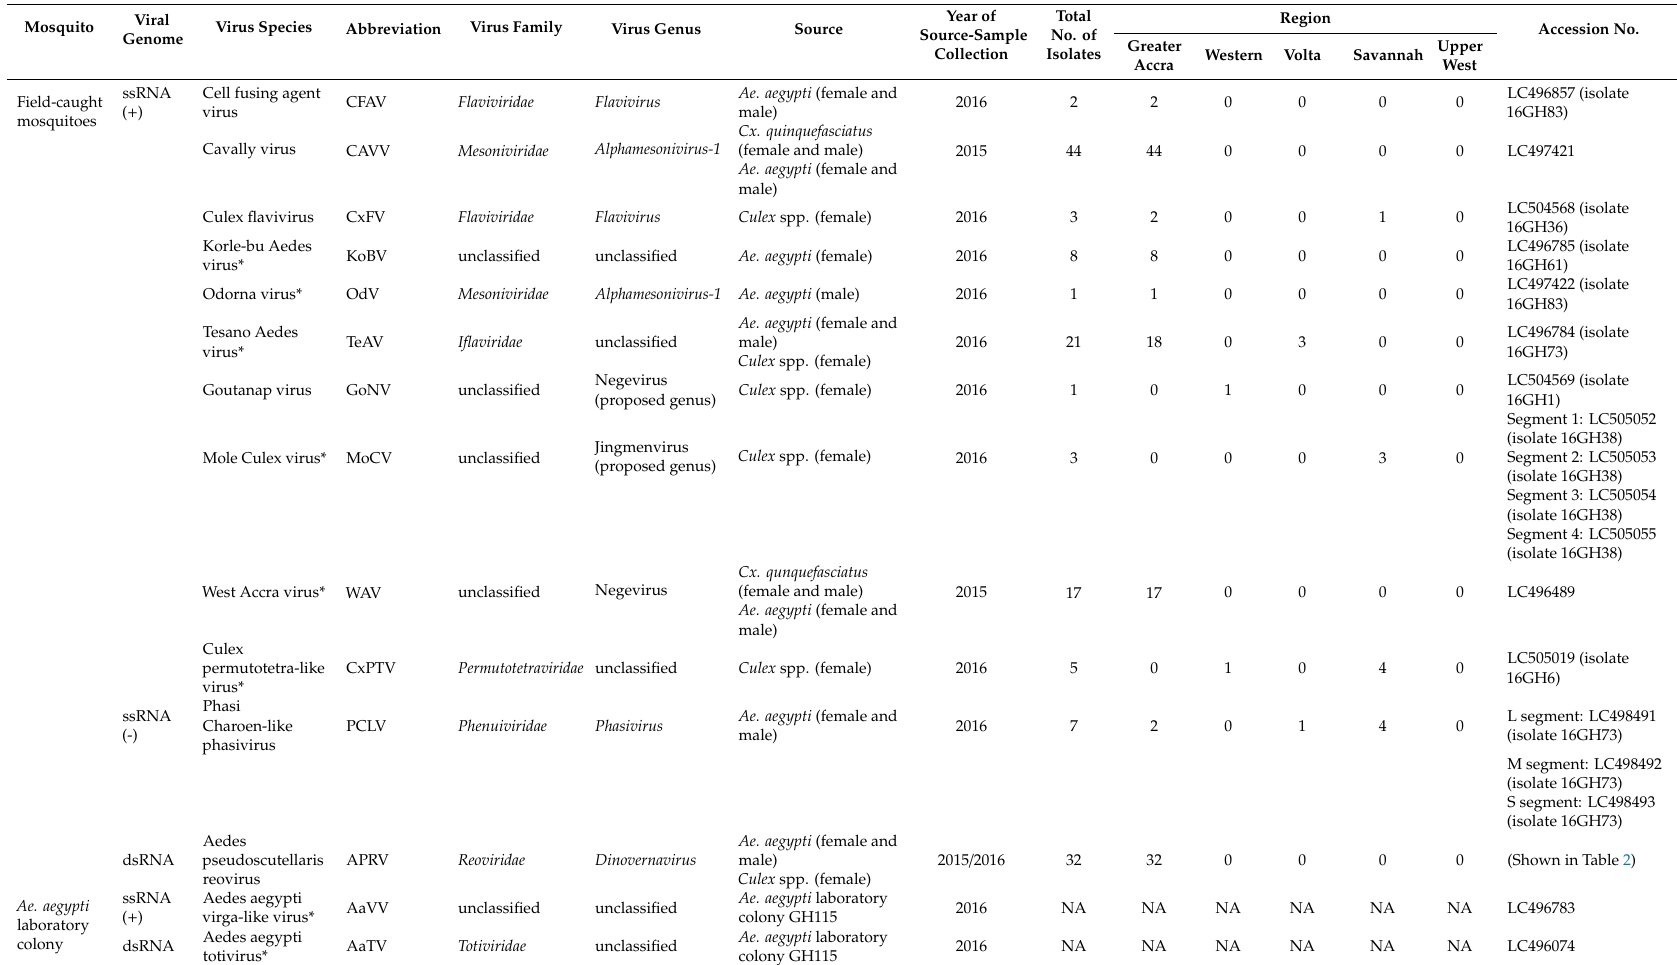
Table 1. Classification and distribution of viruses detected in 2015 and